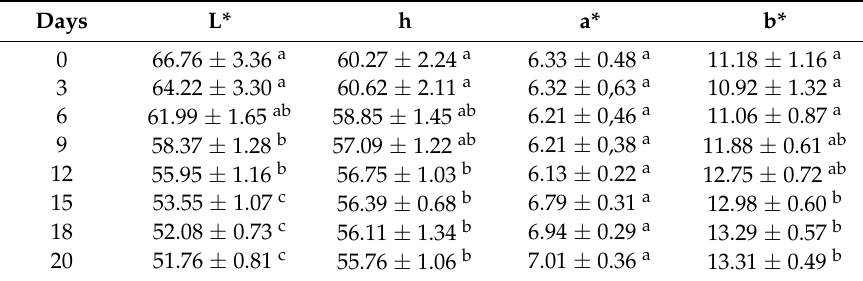
Table A1. Color parameters of boiled turkey hams during refrigerator